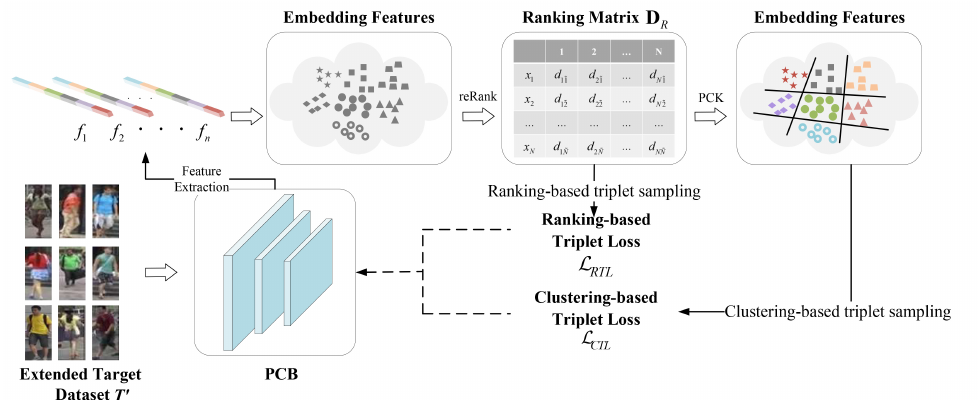
Figure 7. The semi-supervised learning structure. In semi-supervised learning, PCB first extracts the related features. Then k-reciprocal encoding is used to describe the fine difference between any two images, which yields a ranking score matrix D R for the next clustering operation. With the help of partially labeled images in the extended dataset T (cid:48) , semi-supervised clustering PCK-Means is used to mark pseudo-labels for the related data. The whole stage is trained by RTL and